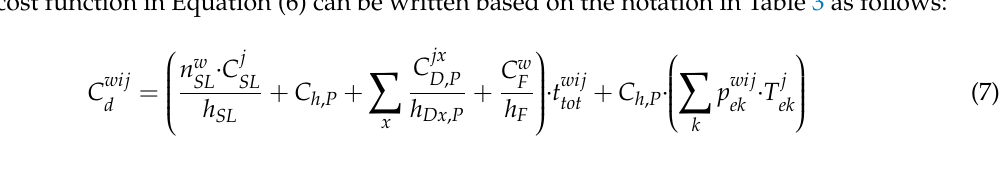
Table 3. Cost function components and